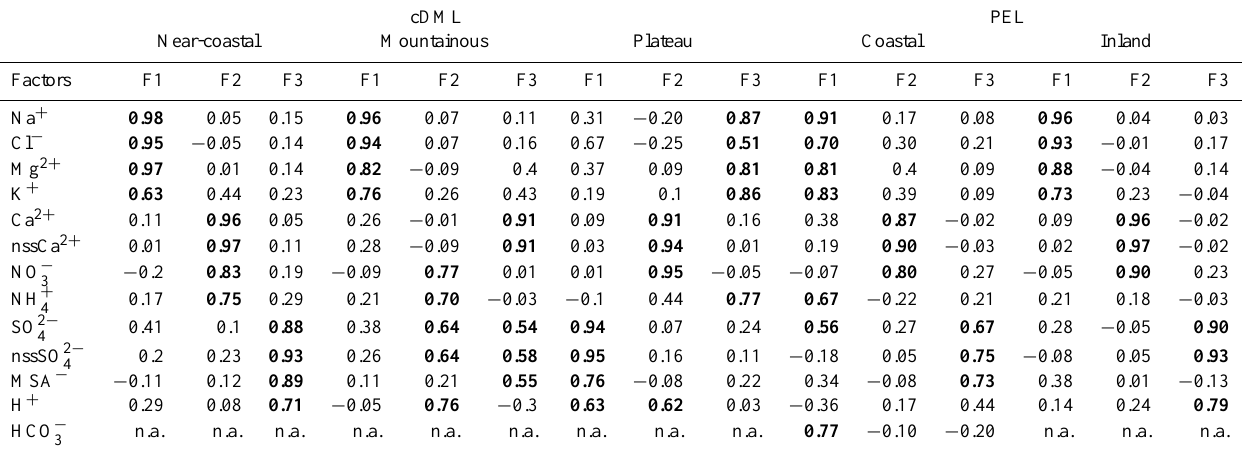
Table 2. PCA results for samples from all sampling regions. Factor loadings above 0.5 are highlighted. cDML PEL Near-coastal Mountainous Plateau Coastal Inland Factors